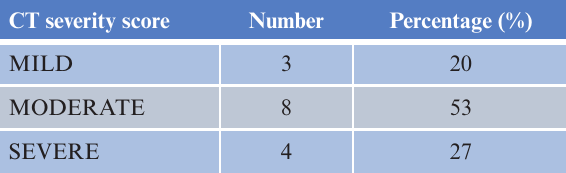
Figure 2: Severity score in COVID-19 renal transplant recipients. Table 3: CT severity score in COVID-19 renal transplant recipients.